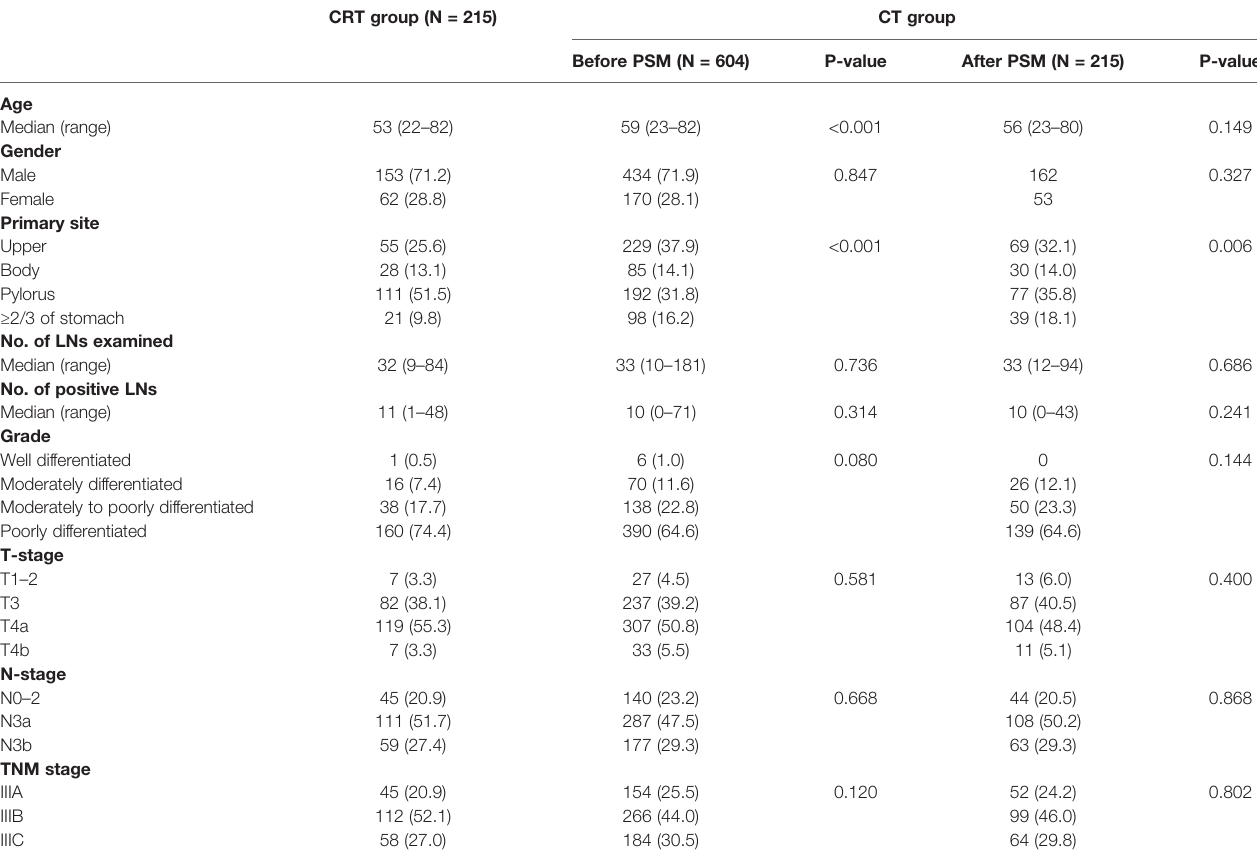
TABLE 1 | Baseline characteristics of patients in the CRT group and CT